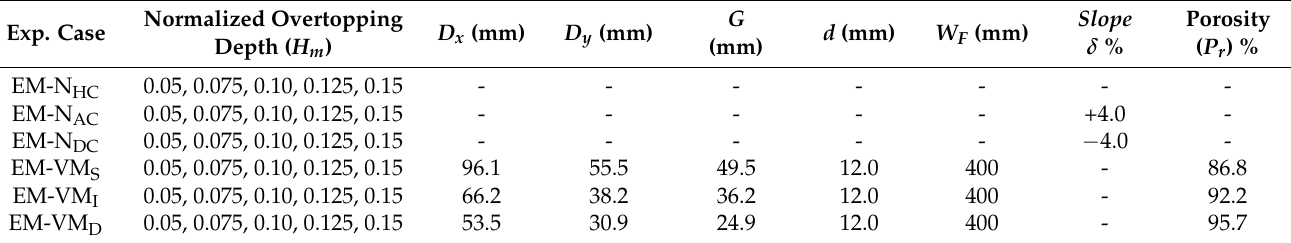
Table 2. Summary of the experimental conditions and vegetation configurations.